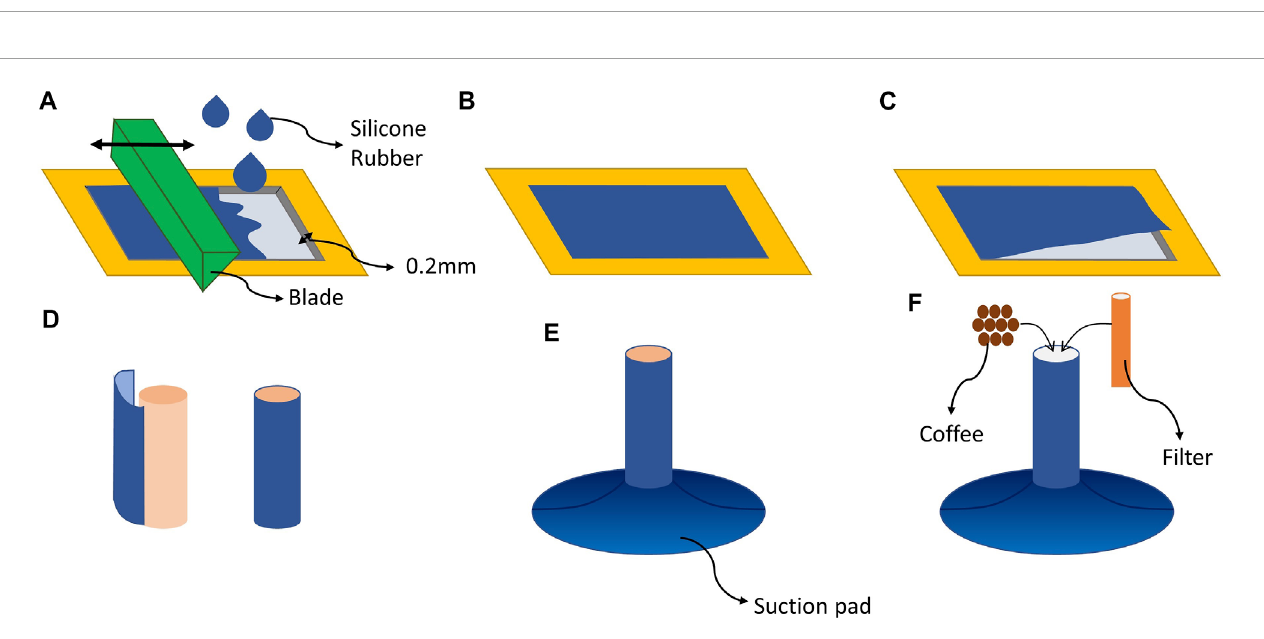
peeled off the film and rounded it on a cylinder with a diameter of 12 mm to attach two sides of the film using the same silicone rubber. Finally, the suction cup was cast on top of the cylindrical film. Based on Cheng et al. (2012), the area in the thin film tube was filled with coffee grains as the granular particle to enhance modulation. In addition to the granular stalk, we cast silicon rubber arms (Ecoflex